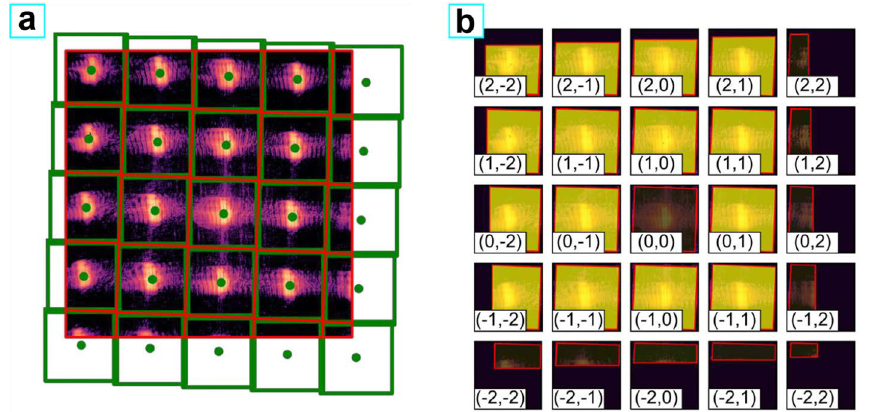
Figure 3. Illustration of the segmentation of the diffraction pattern. ( a ) Voronoi tessellation of the measured data. Centers of masses of sub-patterns corresponding to each of the grating orders are shown with green dots. Red polygons represent individual Voronoi cells fitting in the area of the detector chip. Green squares show the smallest square simultaneously circumscribed about and concentric with the largest Voronoi cell. ( b ) Split data used for the reconstruction. The area highlighted in yellow is inside the corresponding Voronoi cell and is constrained during the reconstruction. Each individual square is equivalent to a measurement from an individual beamlet and represents the individual computational frame used for the propagation of the respective diffraction order. The coordinates of the individual diffraction order at the sample plane can be estimated using the grating-sample distance and the grating parameters. All the data pieces with the less than half of the pixels measured were ignored during the reconstruction (right- and lower- most squares, dark in ( b )). The (0, 0) order was also ignored during the reconstruction due to high levels of parasitic scattering from the beam passing through the frame of the